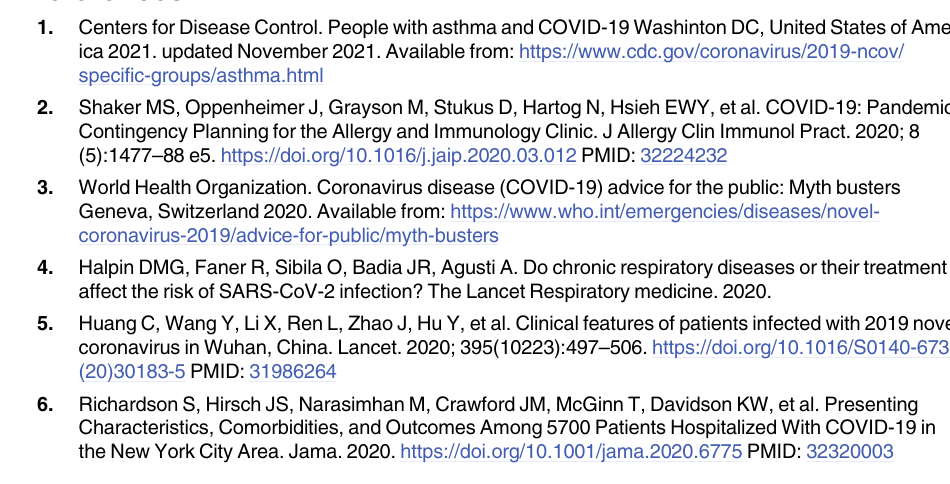
S4 Fig. Monthly ICS and SABA prescription rates by sex, income quintiles, and rural/ urban residence, April 2019-December